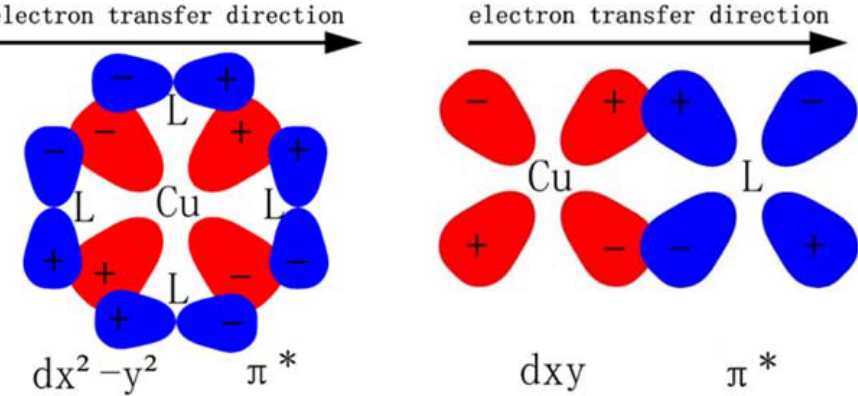
Figure 5. A schematic illustration of the symmetry of the ligand’s π -orbital with the d-orbital of Cu(I) and the charge transfer of the formed metal → ligand.